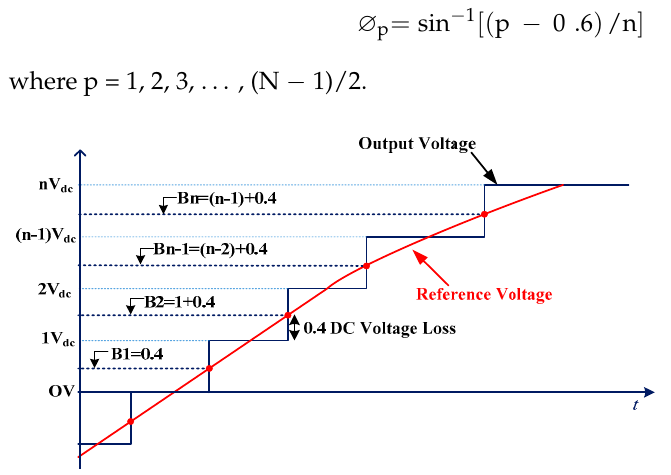
Figure 5. Level generation method of optimized nearest level control.